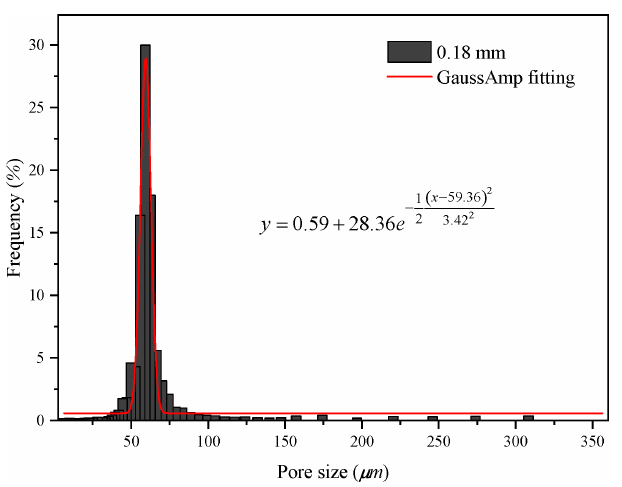
Figure 11. Histogram of the pore size distribution of the permeable stone with a particle diameter of 0.18mm.